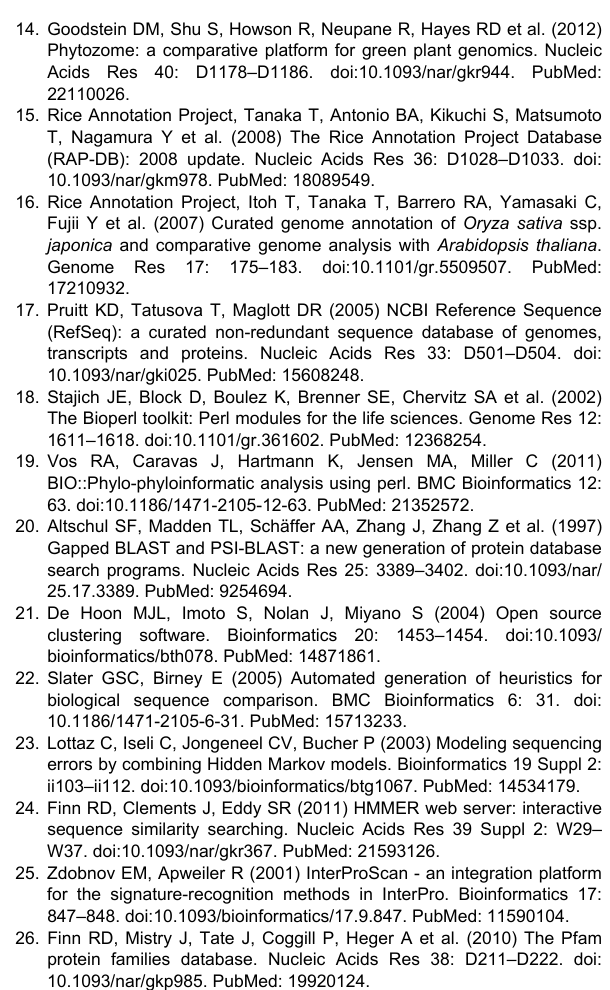
Dataset S3. Phylogenetic tree of all plant Snf2 candidates in NEWICK